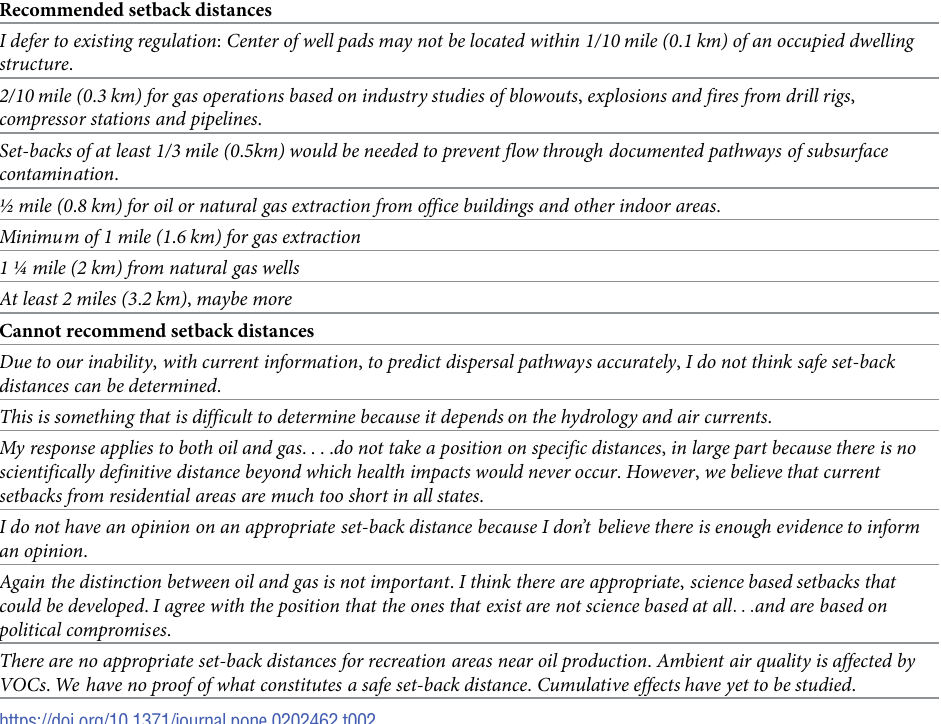
Table 2. A comparison of exemplar statements recommending setback distances and exemplar statements not recommending setback distances from homes, places of work, or recreation areas. Recommended setback